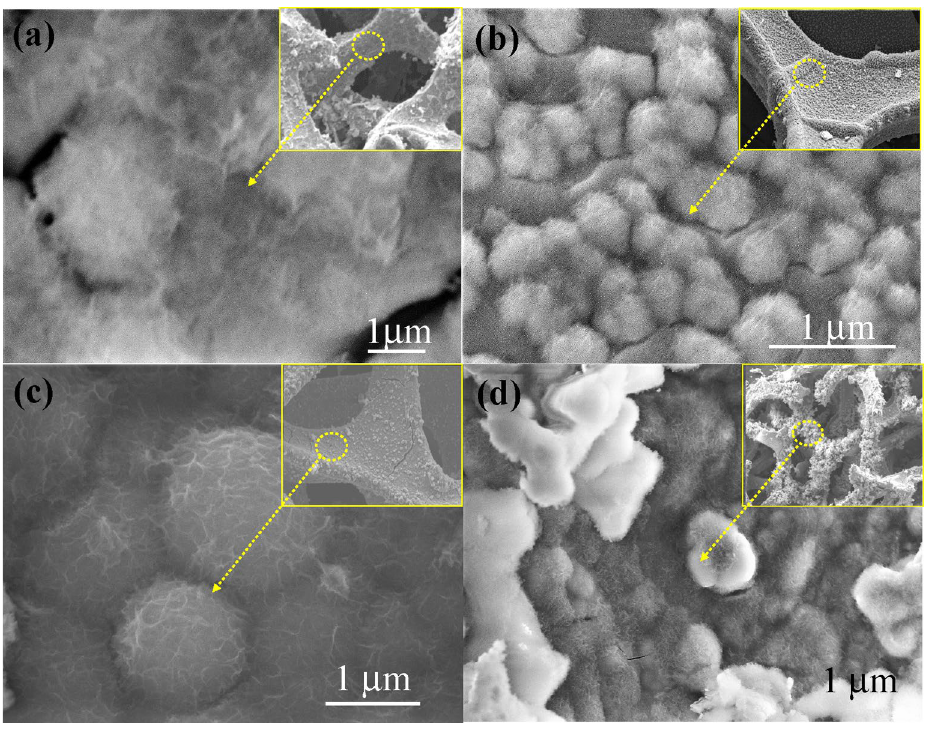
Figure 2. High- and low-magnification SEM images of ( a ) SS-NiS@3DNF-E-1, ( b ) SS-NiS@3DNF-E-2, ( c ) SS-NiS@3DNF-E-3, and ( d )